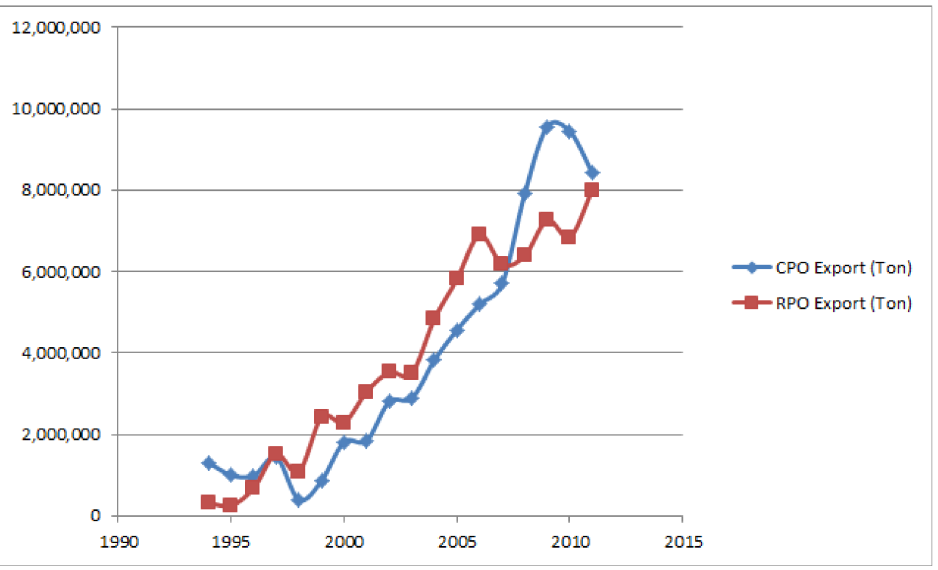
Figure 8. Export of CPO and RPO of Indonesia (UN Comtrade Database, 2014)